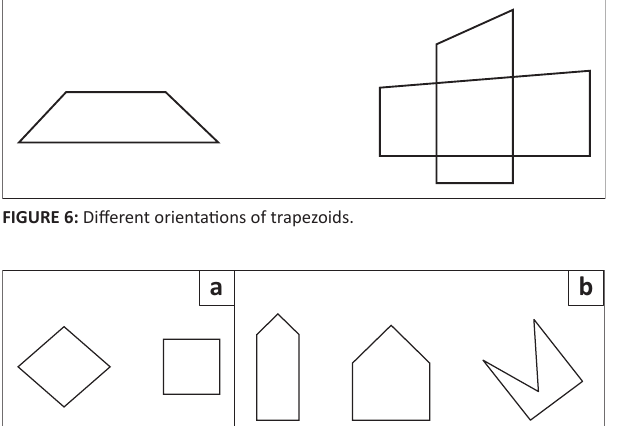
FIGURE 8: The angle subtended by an arc at the centre is twice the angle subtended on the